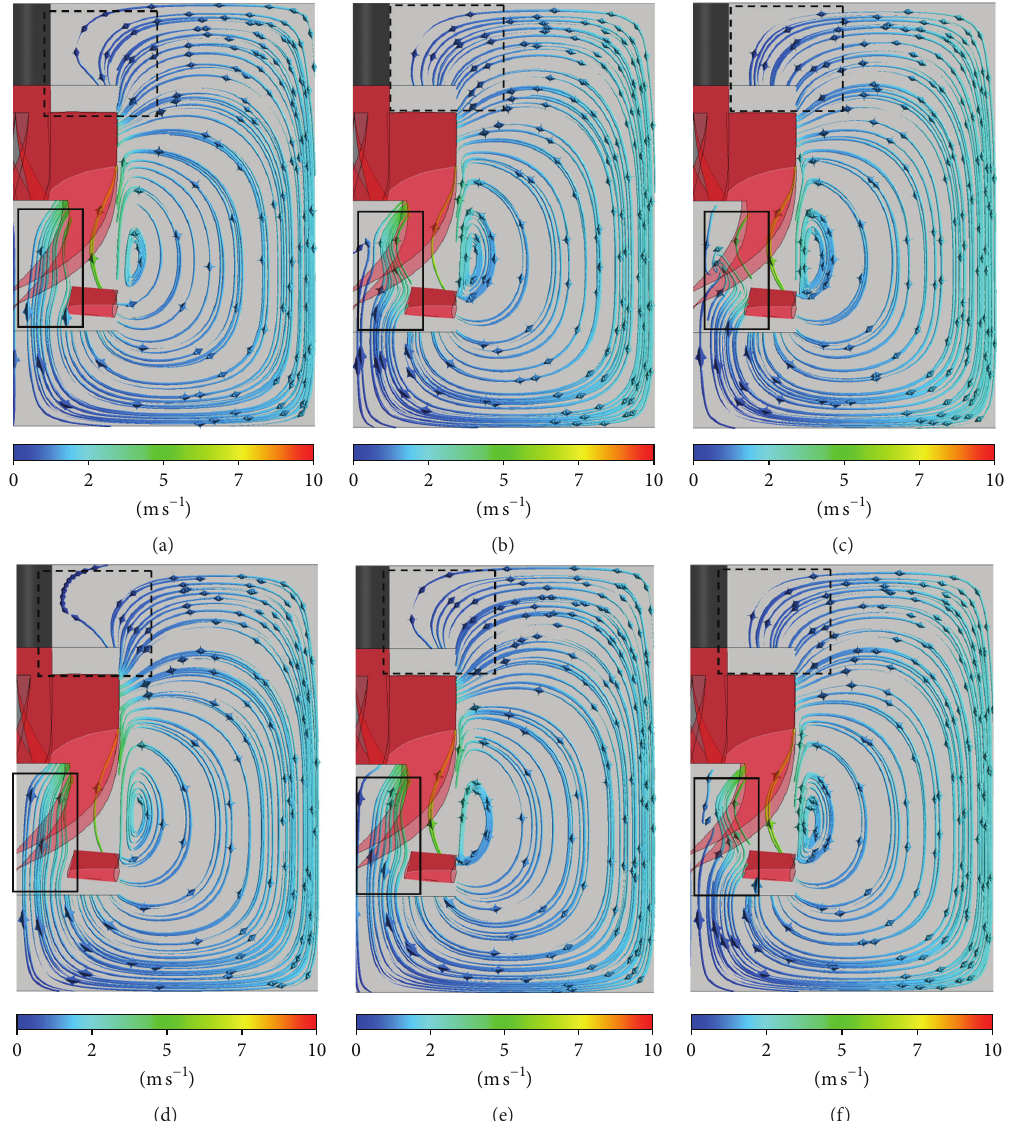
Figure 9: Velocity streamlines at 𝑁 = 1200 rpm (waste tissue pulp: (a) 6.62%, (b) 11%, and (c) 14%. Unbleached kraft pulp: (d) 11.46%, (e) 19.04%, and (f)